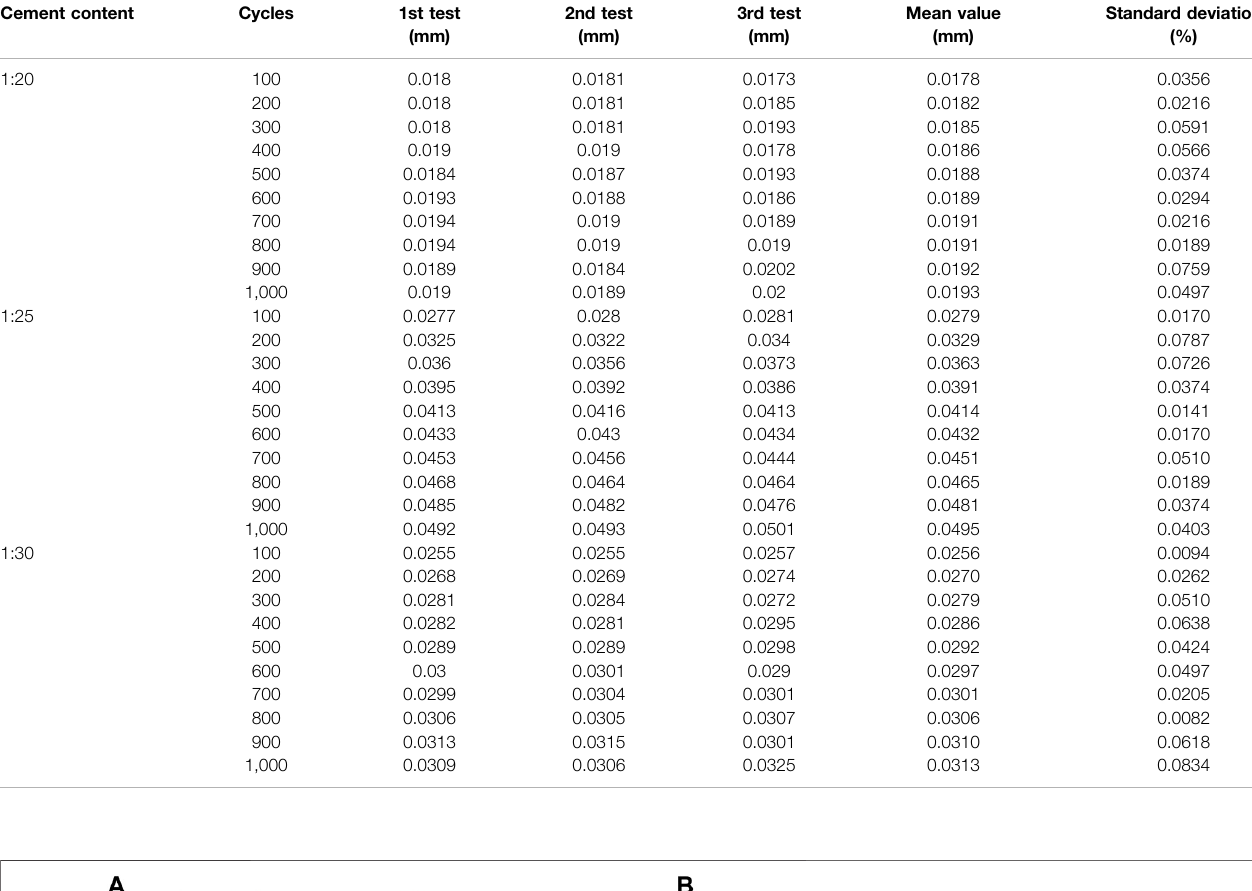
TABLE 4 | Cumulative strain change curve of different cement content under dynamic load.